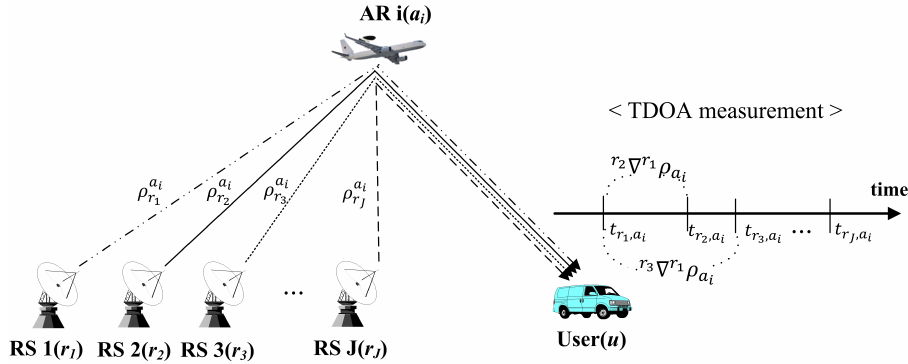
Figure 3. Time difference of arrival (TDOA) measurement in the first